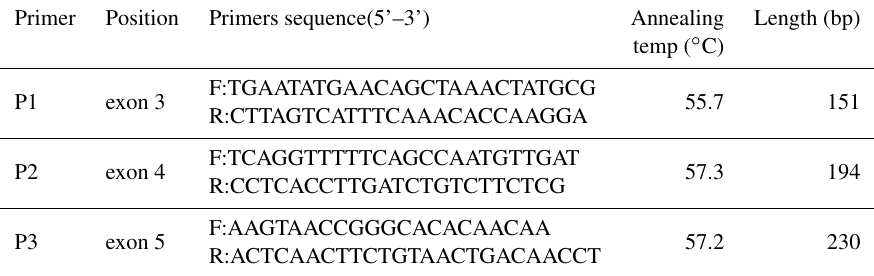
Table 1. Primer sequences of PCR amplification of the chicken Fbxl5 gene.